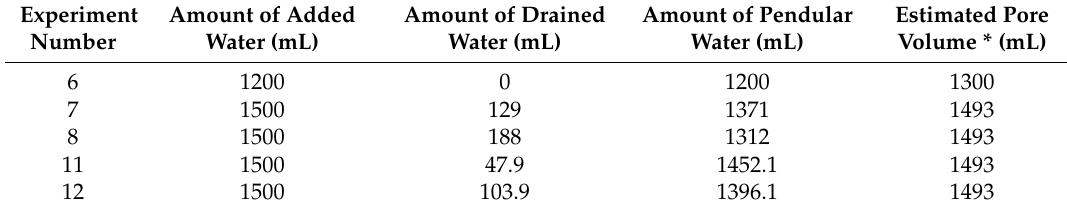
Figure 12. Soil moisture content measured over time in different layers. ( a , b ) show soil moisture measurements over time (seconds) at a depth of 15 cm for hillslope 1 (without macropores) and hillslope 2 (including macropores), respectively. Note the clear effect of different rainfall events; ( c , d ) show soil moisture measurements over time (seconds) at a depth of 40 cm. Note the lack in fluctuations and the constant value of approximately 20% in soil moisture content after application of the first rainfall event. Table 5. Amounts of pendular water in S90